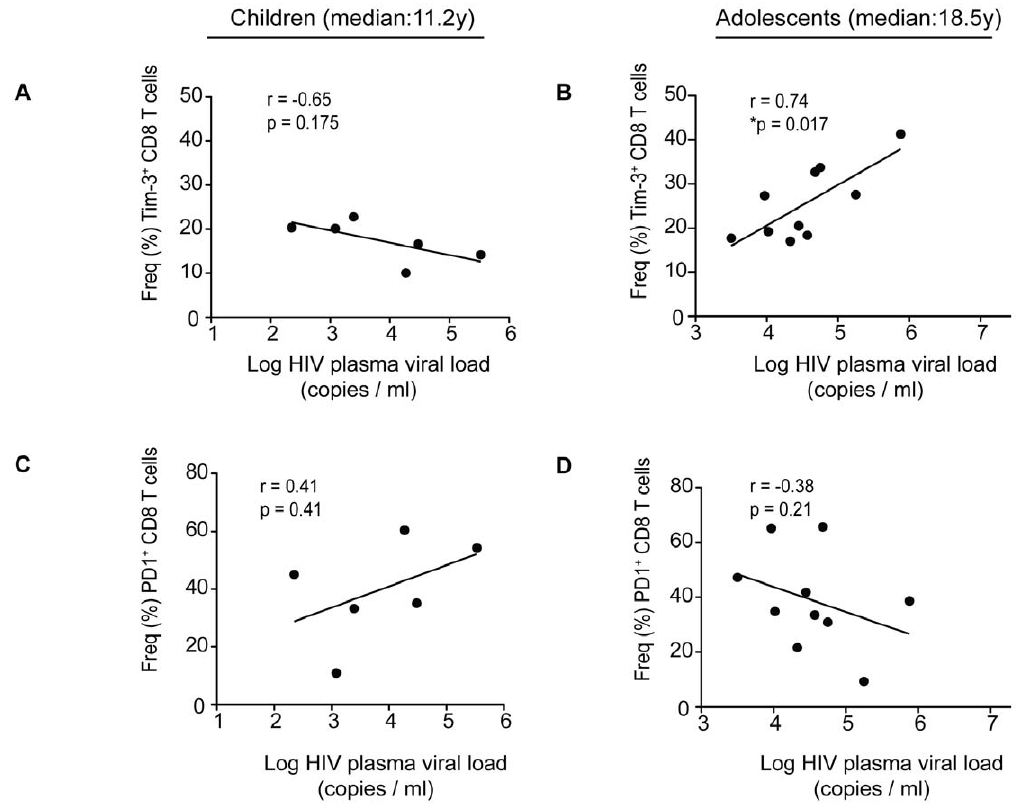
Figure 3. A positive correlation between Tim3 + CD8 + T cells and HIV-1 plasma viral load (VL) in adolescents. Scatter plots showing correlation between HIV plasma viral load (VL) and Tim-3 + CD8 + T cells (A and B), and PD-1 + CD8 + T cells (C and D) in children (left) and adolescents (right) subjects. Tim-3 + CD8 + T cells show a significant direct correlation with HIV-1 plasma viral load (VL) in adolescents (Spearman r=0.74, *p=0.017).